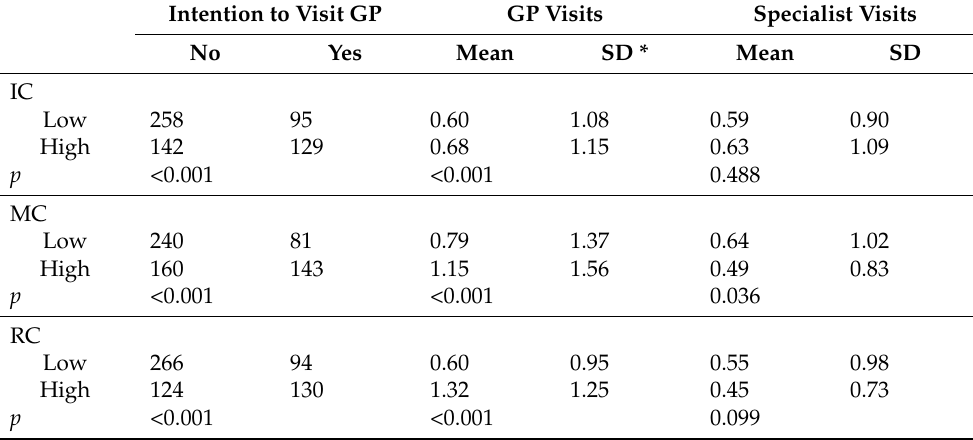
Table 3. Differences in the distribution of different COC levels on intention to visit GP, frequency of GP and specialist